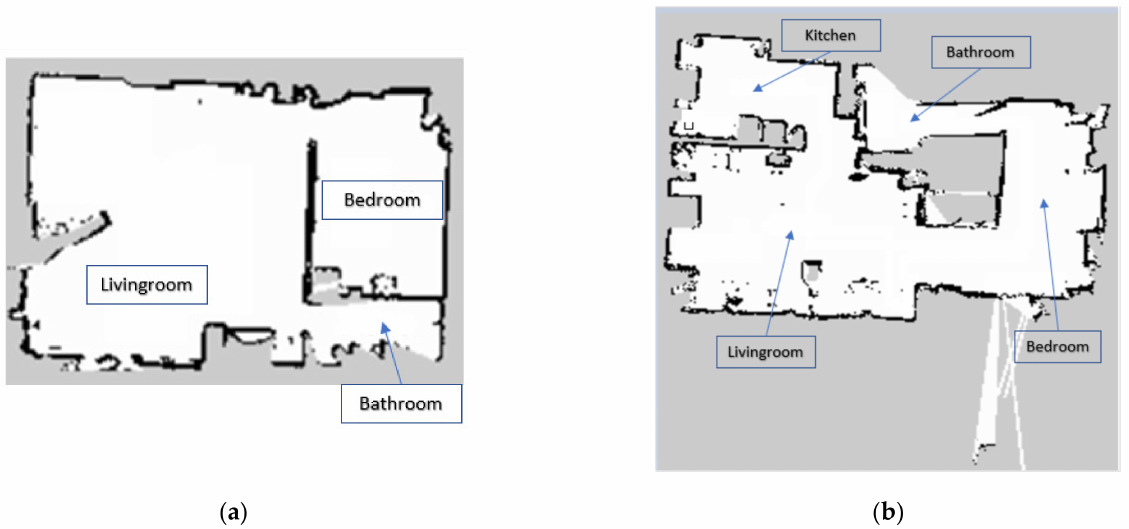
Figure 17. ( a ) Map of the first zone of the house. ( b ) Map of the second zone of the